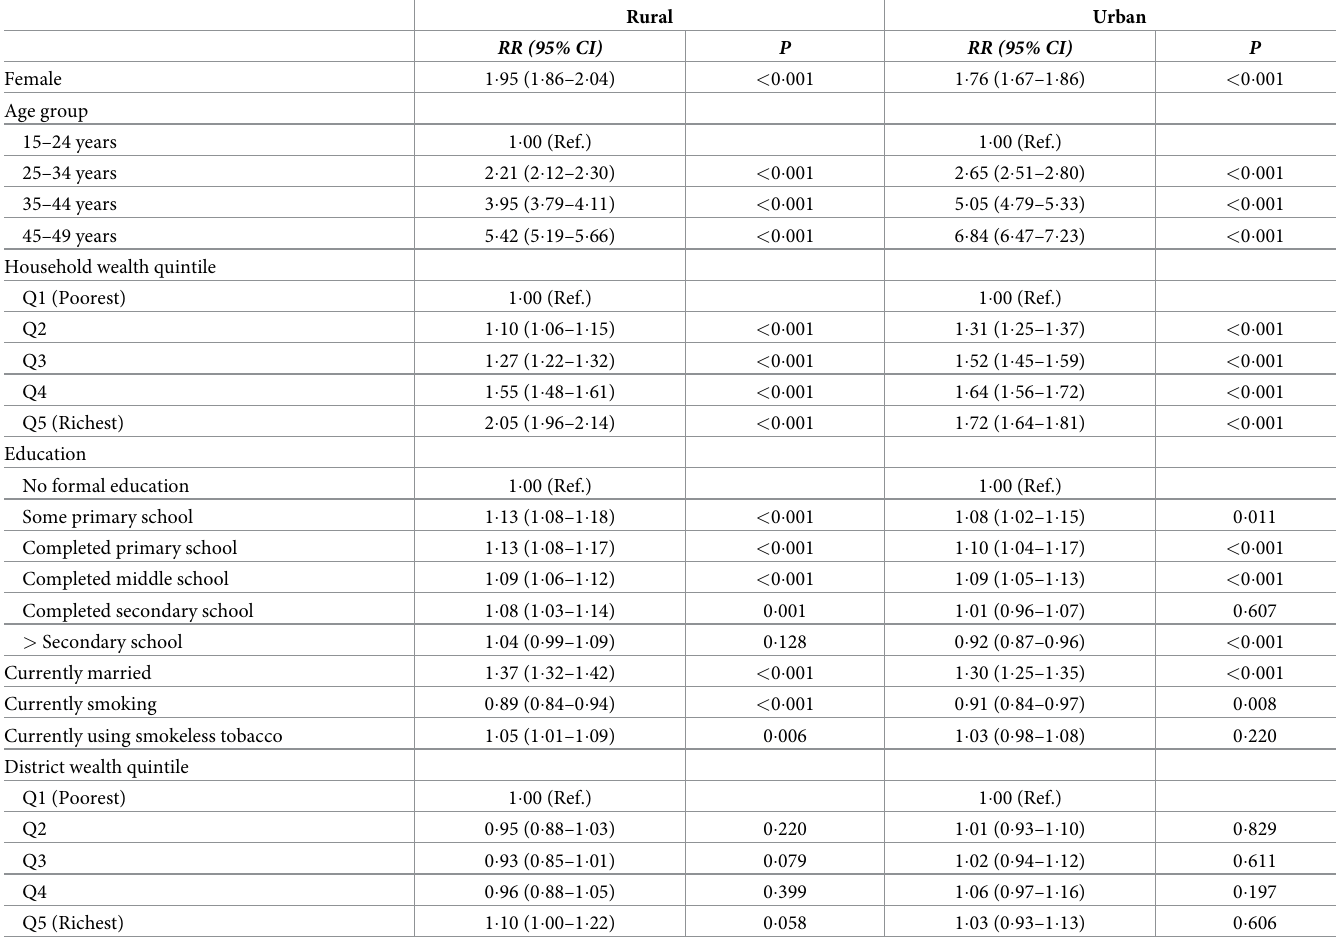
Table 2. Covariate-adjusted regressions of multimorbidity onto individuals’ sociodemographic characteristics and district wealth quintile 1